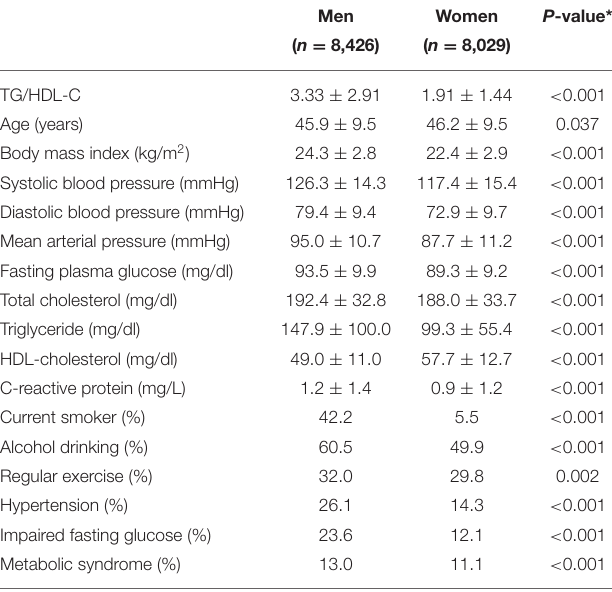
TABLE 2 | Clinical and biochemical characteristics according to